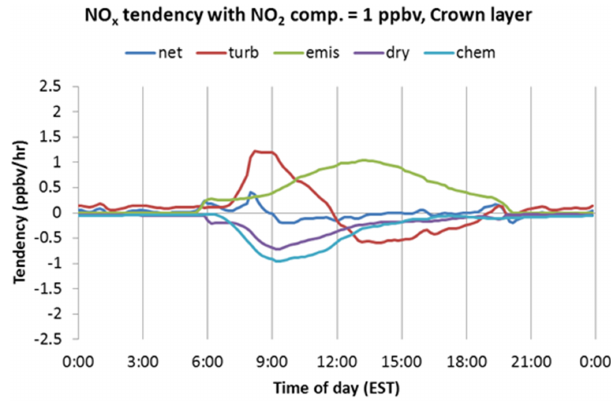
Fig. 12. Similar to Fig. 11a but showing the simulated August mean diurnal cycle in NO x process tendencies (ppbvh − 1 ) for the crown layer for an assumed NO 2 compensation point of 1 ppbv .